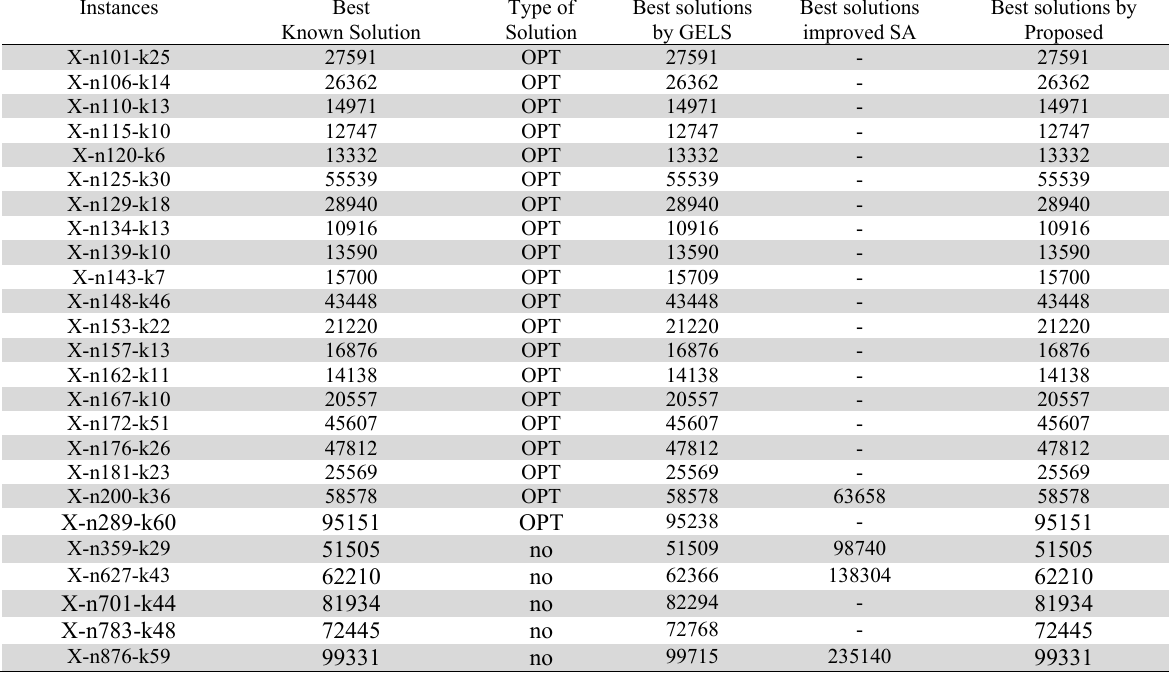
Table 5 Comparison proposed algorithm with other algorithms